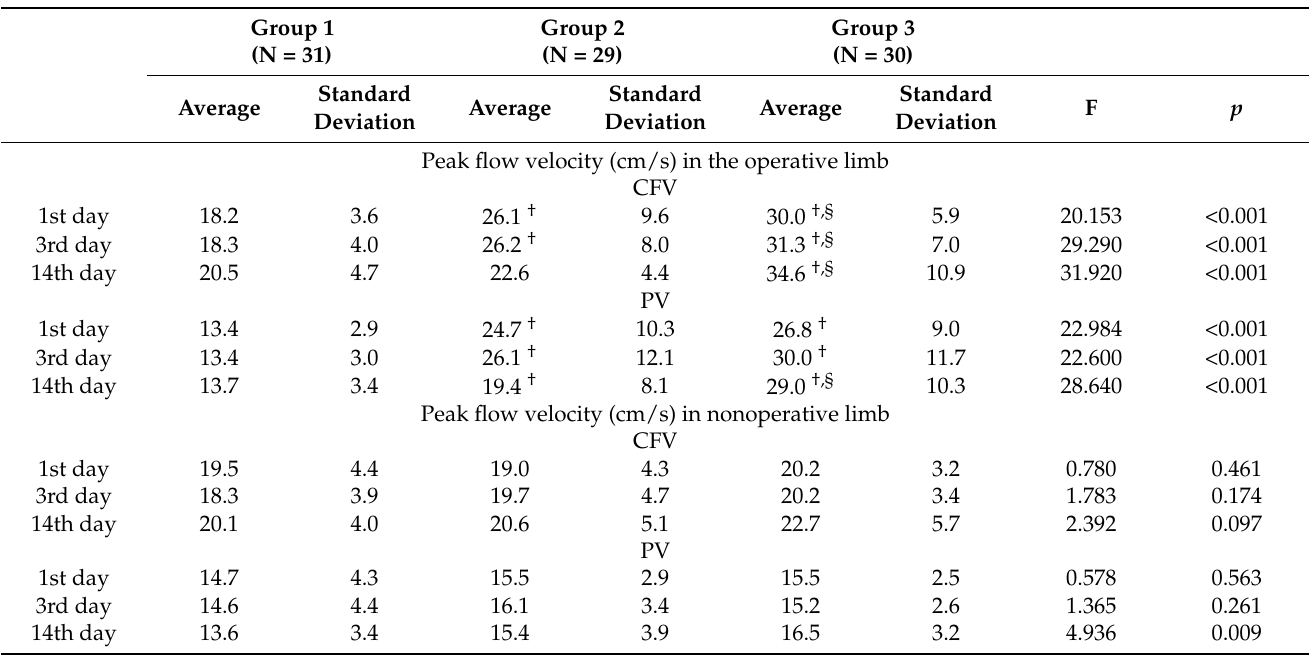
Table 2. Peak flow velocity in the common femoral vein (CFV) and popliteal vein (PV) after the